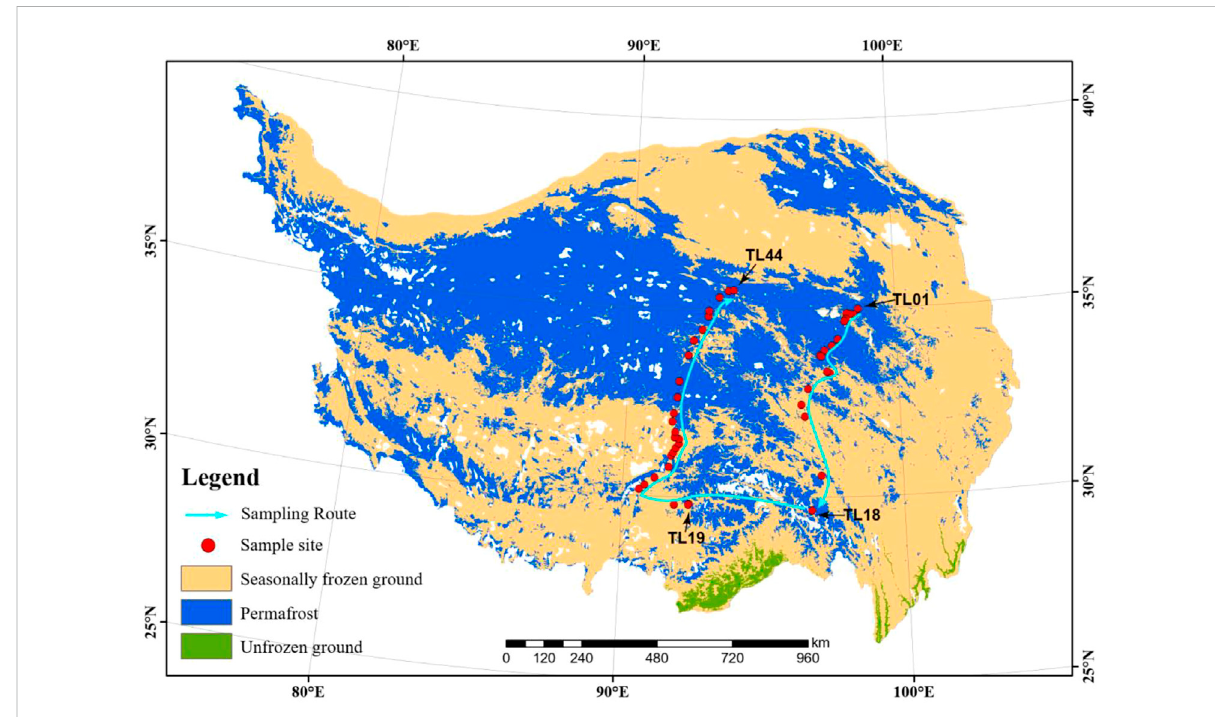
FIGURE 1 Map of the 44 sampling sites of permafrost soil and thermokarst lake sediment across the Qinghai-Tibet Plateau. The distribution of the permafrost was cited from Zou et al., 2017. The map was cited from Ren et al.,